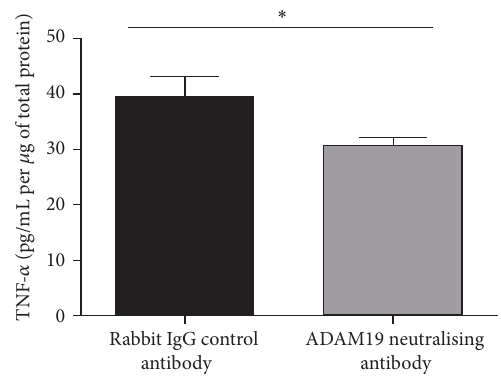
Figure 7: Neutralisation of ADAM19 reduces liver TNF- 𝛼 levels in HFD-fed mice. Mean + SEM; ∗ 𝑝 = 0.05 ; 𝑛 = 3